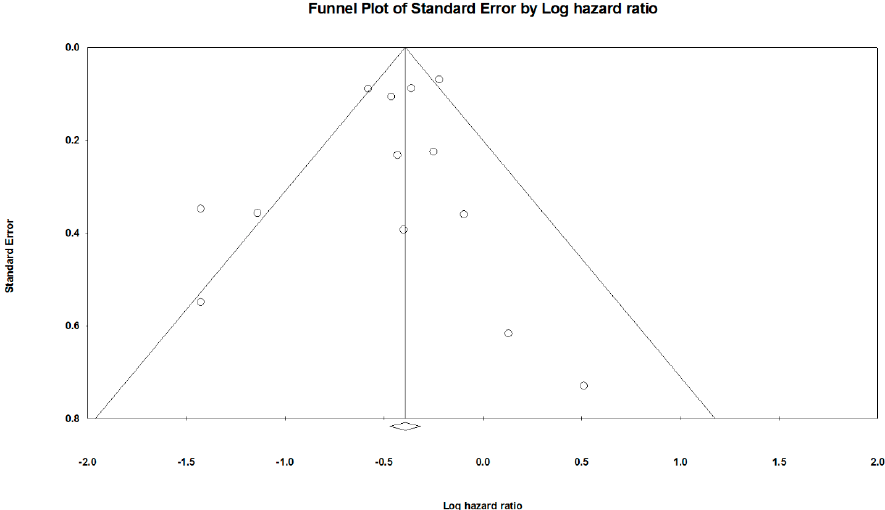
Figure 5. Funnel plots of pooled randomized controlled trials and retrospective studies.